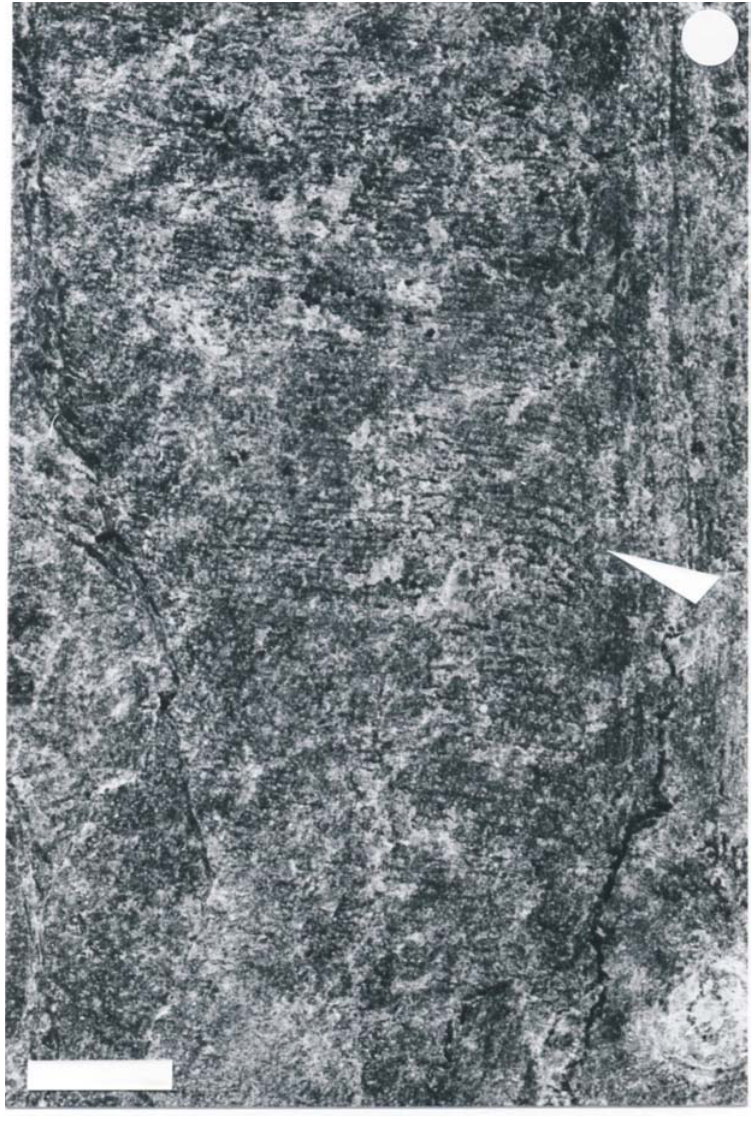
Fig. 3 – Part of the leaf illustrated in Fig. 2 (A) [MP-Pb 3576A] enlarged to show details of taeniopteroid venation (arrow). Scale bars: 0.5